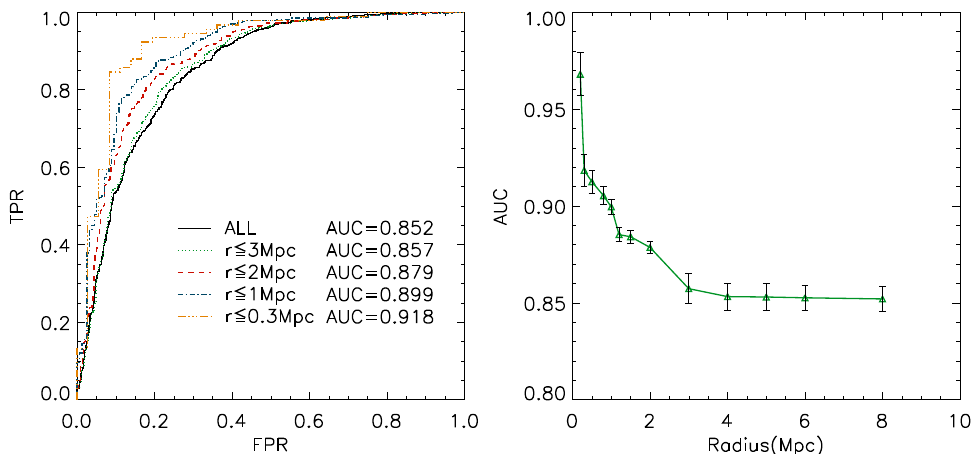
Figure 6. The ROC curves for various validation apertures ( left panel) and the AUC scores for various validation apertures ( right